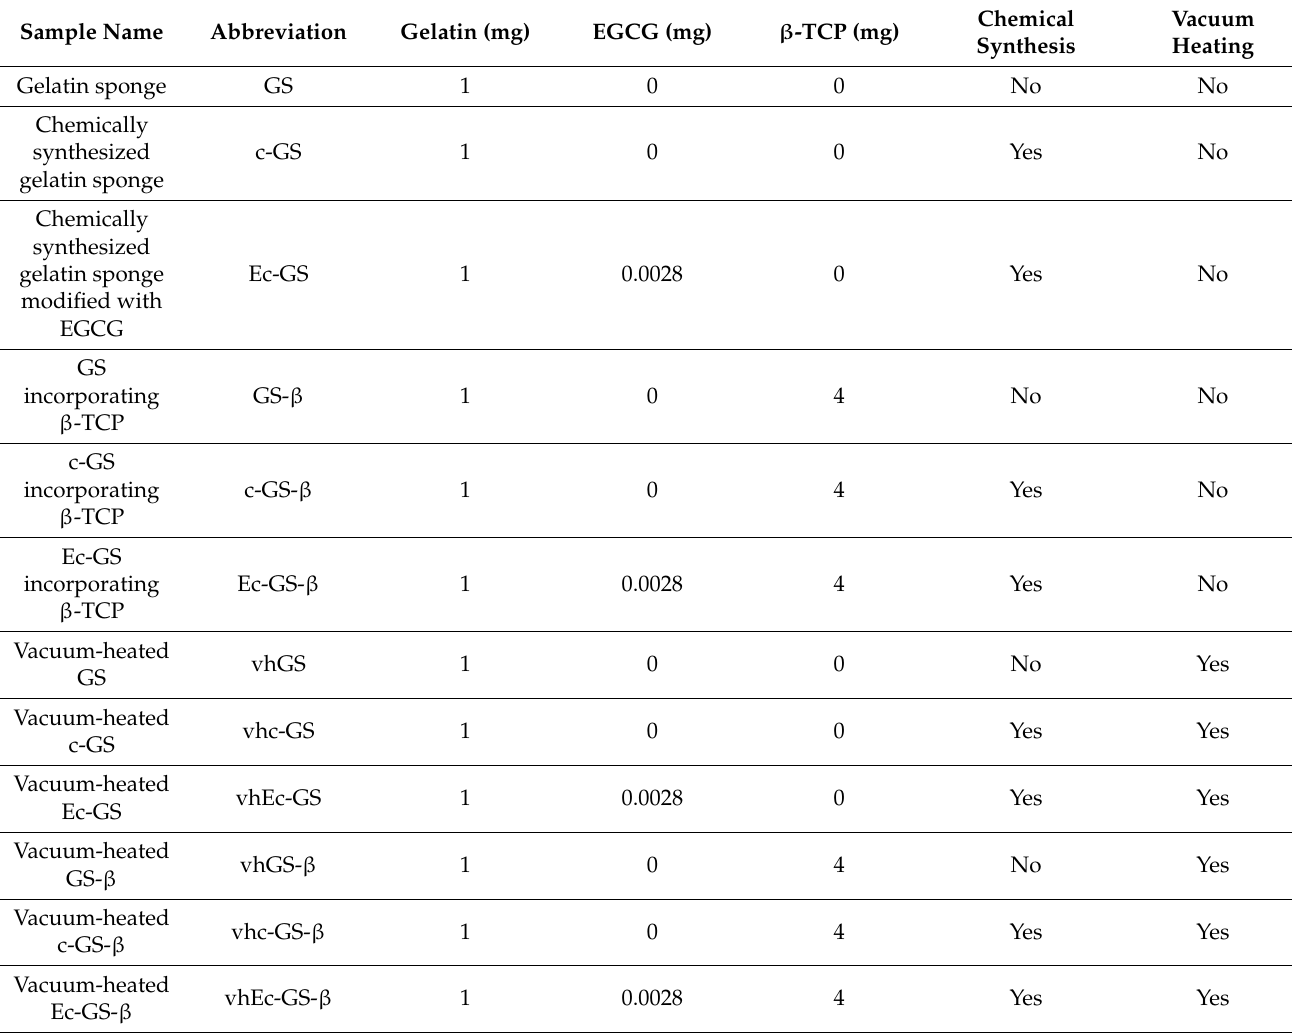
Table 1. Summary of prepared